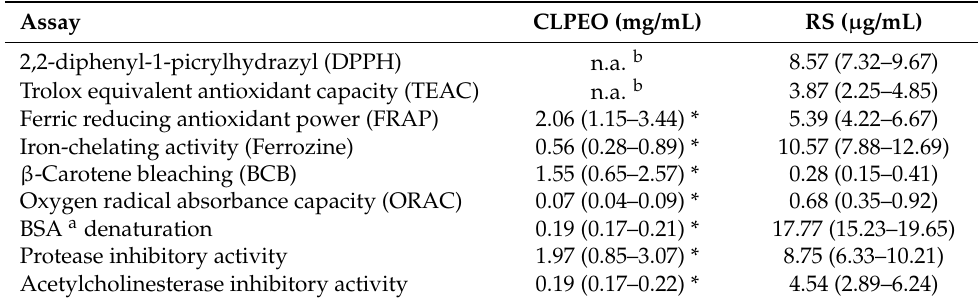
Table 3. Determination of the antioxidant and anti-inflammatory activities of the C. lumia ‘Pyriformis’ EO (CLPEO) using several in vitro assays based on different environment and reaction mechanisms. The results are expressed as a half-maximal inhibitory concentration (IC 50 ) with confidence limits at 95% in parentheses, representing the mean of three independent experiments in triplicate, and are compared to the reference standards